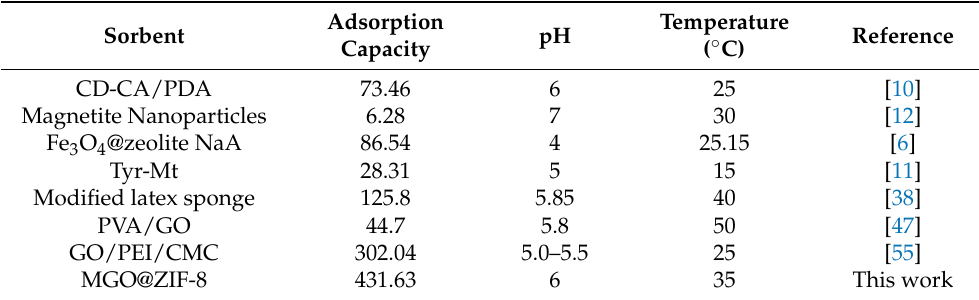
Table 3. Comparison of Cu 2+ adsorption capacity of MGO@ZIF-8 with similar and other previously used adsorbents.